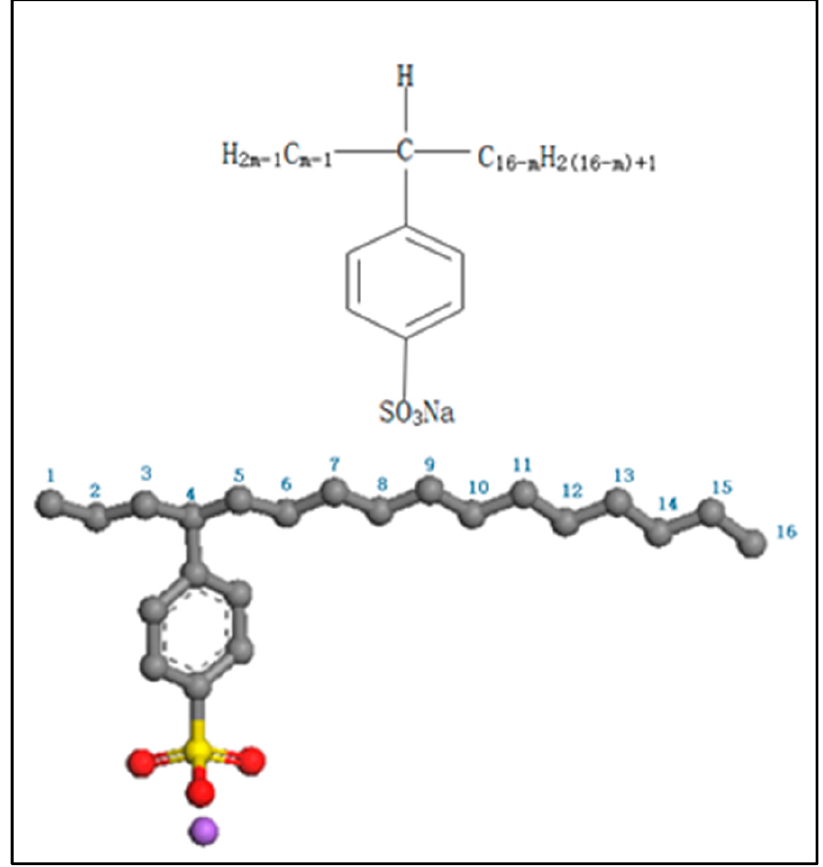
Figure 1. The isomers of SHS (m = 2,4,6, and 8), and the example shown is 4 ‐ C16. Through computer simulation, the microstructure and macroscopic properties of the surfactant system can be linked. In particular, MD simulation has proven to be a very useful tool for studying the structure and dynamics of surfactants at the molecular level. At present, a large number of MD simulation studies have been conducted on the diffusion of other surfactants on the surface of coal [29–31], but there are few studies on the diffusion characteristics of LAS on the surface of coal [20,24]. In the previous research work, we used molecular dynamics simulation to explore the microscopic reasons for the different diffusion characteristics of SDS and SDBS on the surface of anthracite [32] and concluded that the presence of benzene rings in the surfactant has an important impact on the diffusion characteristics. Liu et al. [24] compared a large number of surfactants with different structures through experiments and concluded that the presence of the benzene ring in the surfactant has a significant impact on the hydrophilicity of coal. In order to further explore the microscopic mechanism of the influence of the benzene ring on diffusion characteristics, in this study, we applied the four isomers of SHS of the LAS family. We chose the four isomers of the LAS family because they exist in nature and the only difference they have is that the benzene ring has a different connection position on the carbon chain. The above two reasons lead us to believe that these four isomers are the ideal materials we need, which can realize the subject of “the influence of different attachment sites of benzene ring in the backbone” well that we want to study. MD simulations were performed. As far as we know, this is the first attempt to